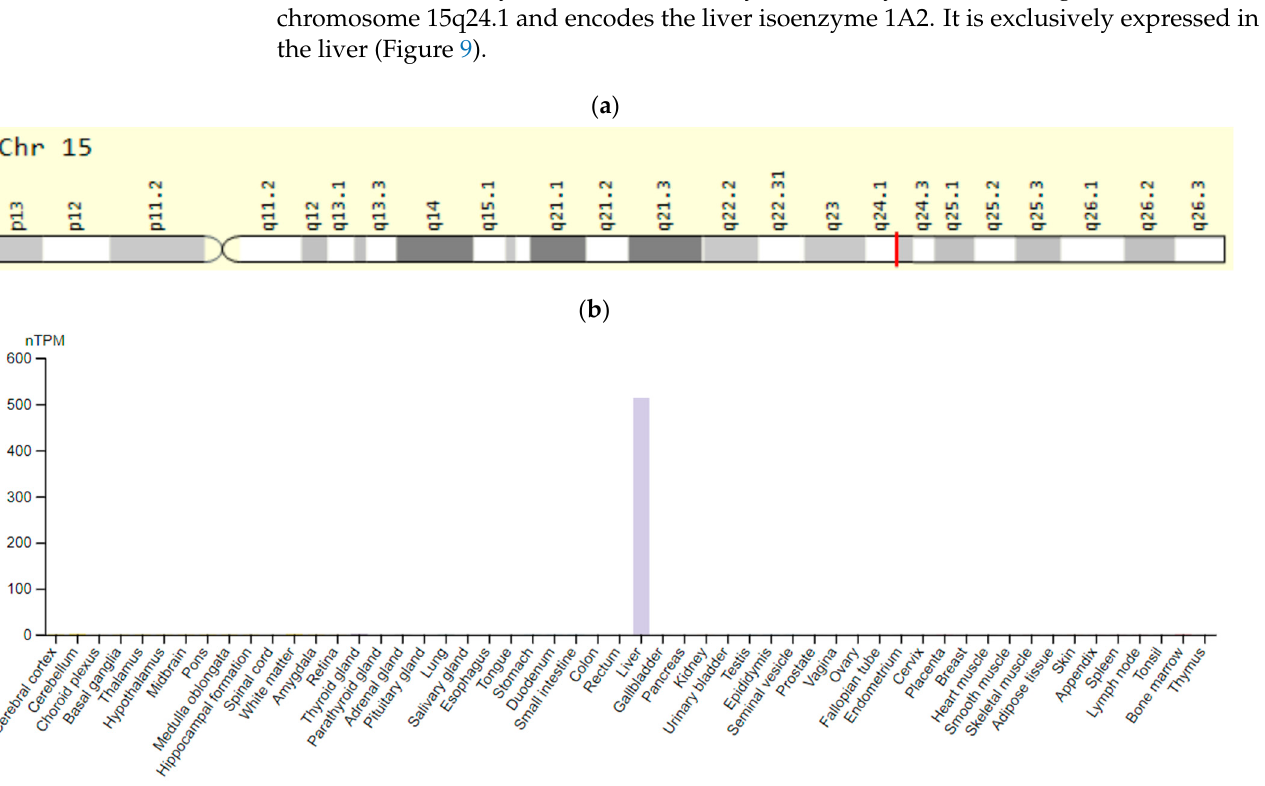
Figure 8. The CYP3A5 gene: ( a )–gene chromosome location; ( b )–protein expression in tissues of the human body [82,83].